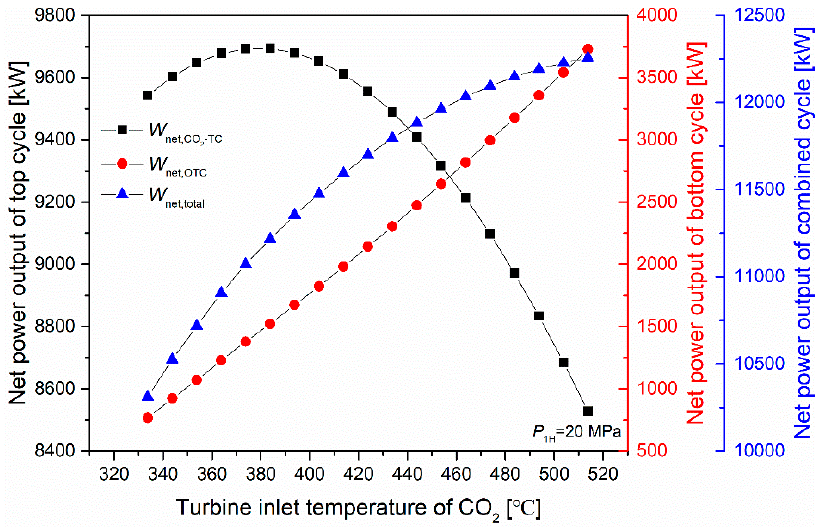
Figure 6. Variations of net power output with turbine inlet temperature of CO 2 for CO 2 -TC+OTC. The variations of net power output with the turbine inlet pressure of CO 2 ( P 1H ) are shown in Figure 7. The T 1H is kept at the upper limit of 518.8 °C. The thermal efficiency and heat addition of